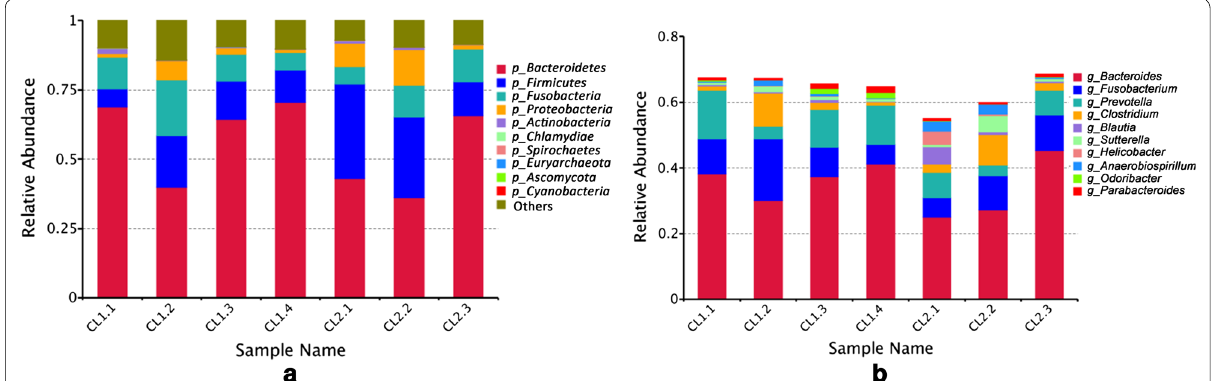
Fig. 2 The relative abundances of dominant bacteria in each sample at a the phylum level and b the genus level